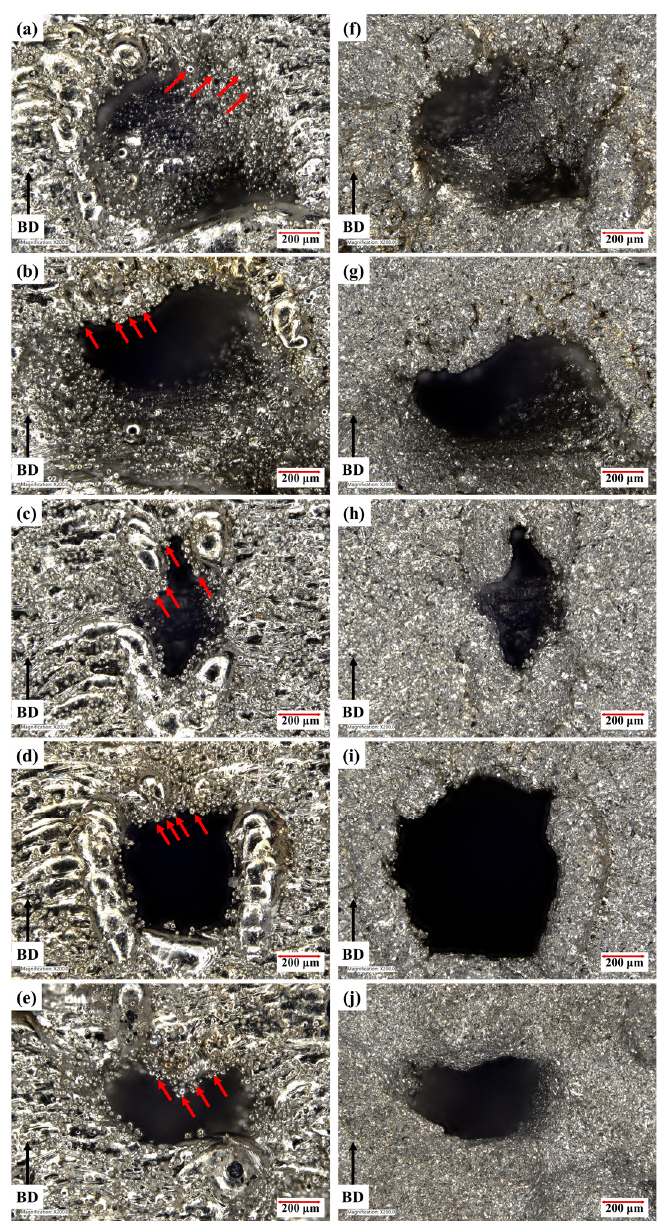
Figure 3. Optical micrographs along the build direction showing the unmelted powder particles highlighted with arrows attached to the surface for the as-built samples ( a ) Diamond, ( b ) Gyroid, ( c ) Neovius, ( d ) Primitive, and ( e ) Fisher–Koch S and the corresponding surfaces after sandblasting for ( f ) Diamond, ( g ) Gyroid, ( h ) Neovius, ( i ) Primitive, and ( j ) Fisher–Koch S samples.